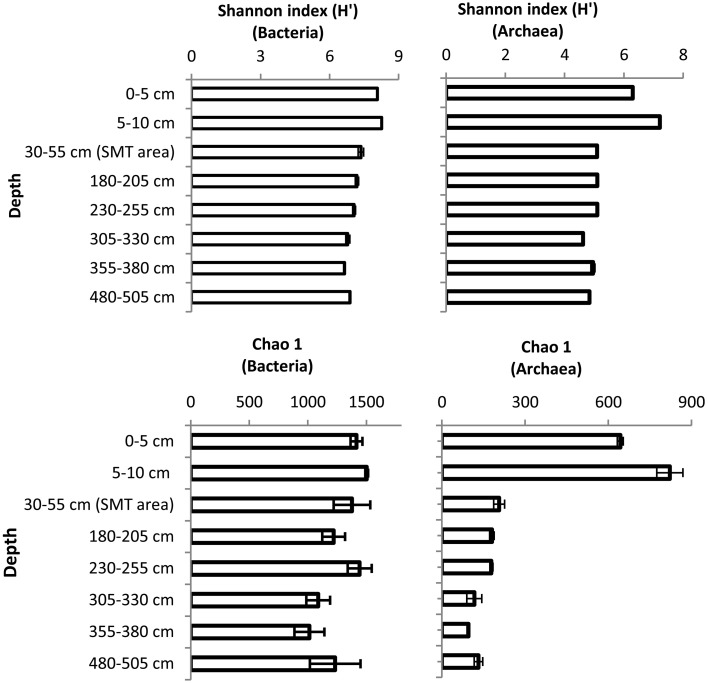
Shannon and Chao1 diversity indices of Bacteria and Archaea in surface and deeper sediments of the Helgoland mud area. Error bar are standard deviations for results of calculations of diversity indices over three iterations.